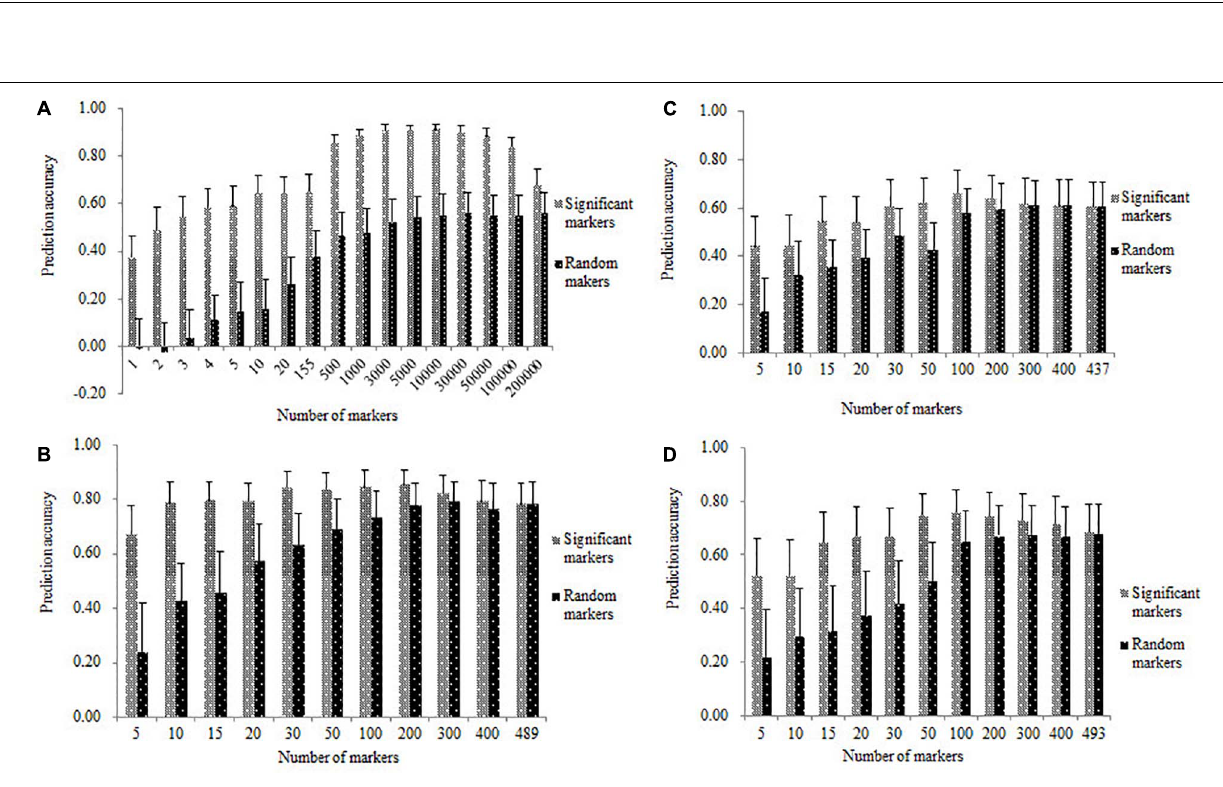
Frontiers in Plant Science |